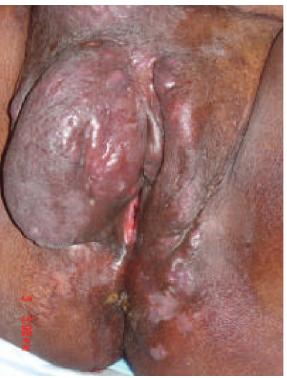
Figure 2: Erythema and draining sinus tract at the superior aspect of the right labial mass.